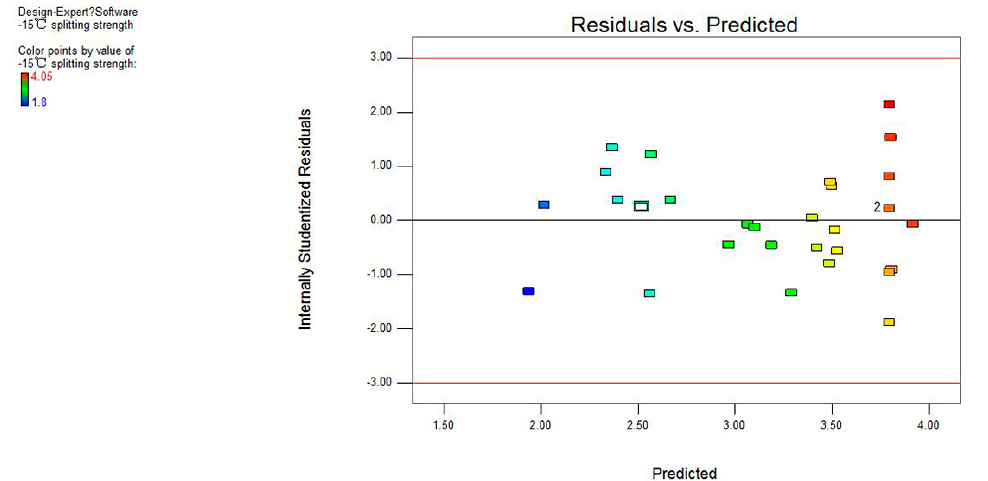
Figure 4. Residual versus predicted values of − 15 °C splitting strength.